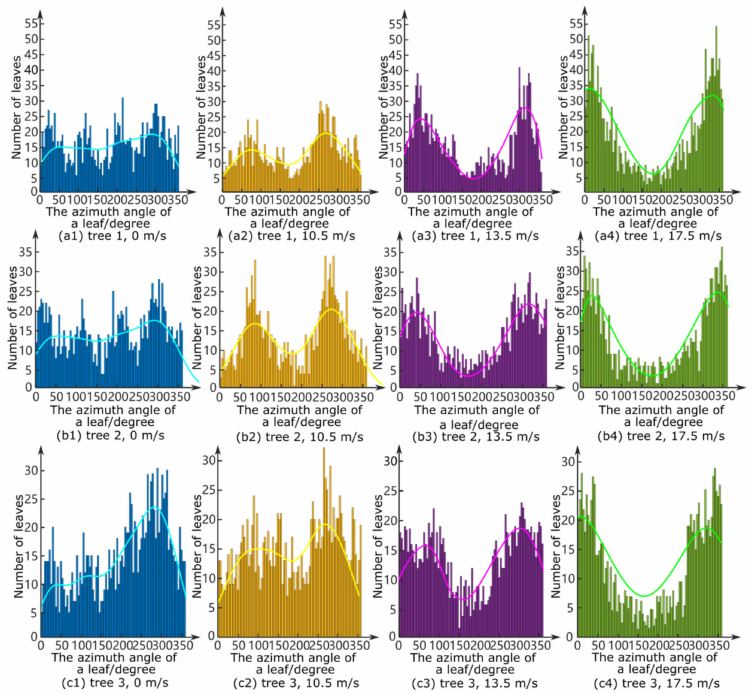
Figure 8. ( a1 – c4 ) illustrate the distribution of the azimuth angle for individual leaves of the three rubber trees under various wind loading at four speeds, i.e., 0 m/s, 10.5 m/s, 13.5 m/s, and 17.5 m/s,